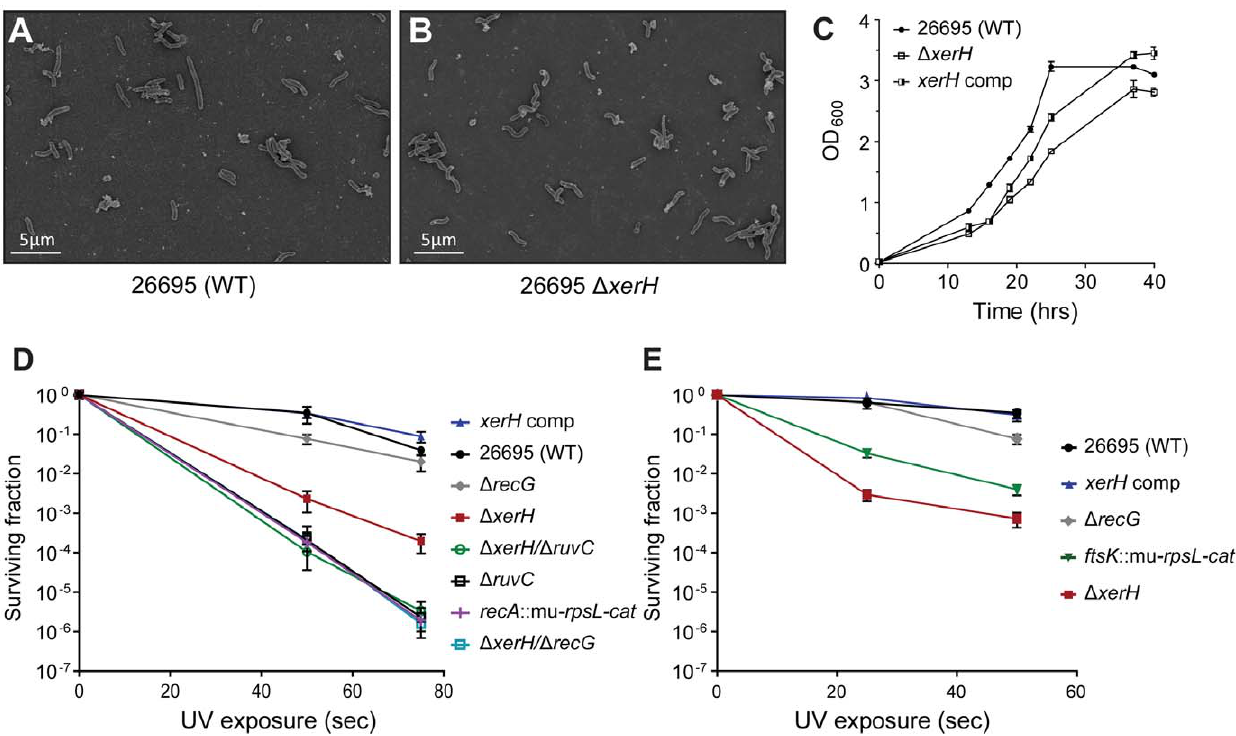
Figure 6. Phenotypes of H.pylori recombination mutants. (A) and (B) Electron micrographs. WT and D xerH mutant cells were fixed with glutaraldehyde and processed for scanning electron microscopy. Both WT and D xerH mutant cells displayed the characteristic curved rod morphology; in contrast to D xer mutant E. coli , none were filamentous. (C) Growth curves of H. pylori in liquid medium. Cells were grown in BHI liquid medium supplemented with 10% NCS in microaerobic conditions with agitation. The optical densities (OD 600 nm ) of WT, D xerH and complemented strains were measured in triplicate for up to 40 h. (D) UV sensitivity of WT and recombination mutant H. pylori . Cells were exposed to UV light as described in the methods and viable colony forming units (survival) was determined. Each test was repeated at least three times; standard deviation is indicated. (E) UV sensitivity of WT and ftsK mutant H. pylori determined as in part D.